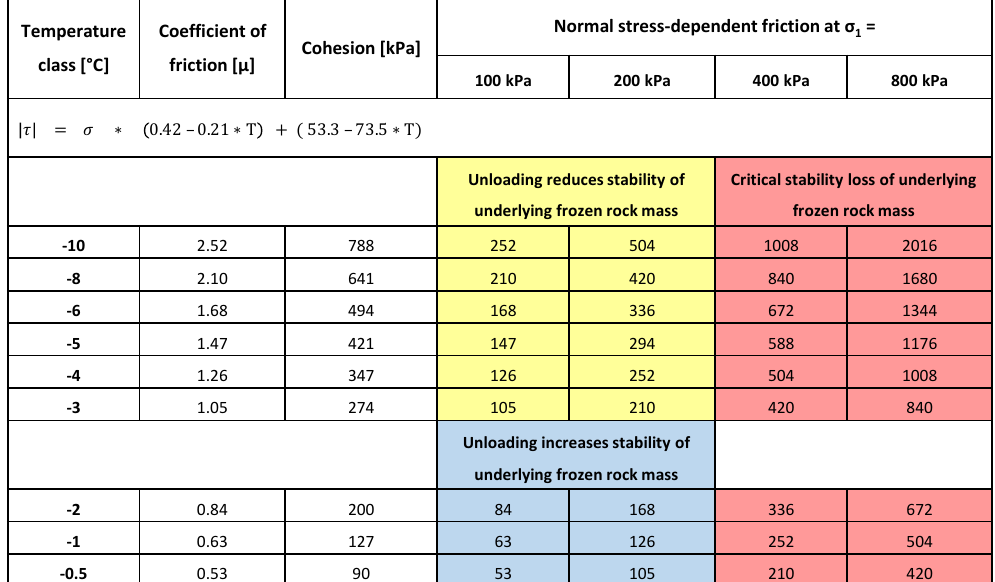
Figure 11. Three scenarios of rock slope stability after the sudden unloading of an underlying frozen rock mass with 45 ◦ fractures. Blue boxes: increasing stability of underlying frozen rock mass. Unloading increases shear resistance relative to shear forces in 45 ◦ fractures. Yellow boxes: reducing stability. Unloading reduces shear resistance (friction) relative to shear stress in 45 ◦ fractures. Red boxes: critical stability loss. Friction loss along underlying 45 ◦ fractures even exceeds ice